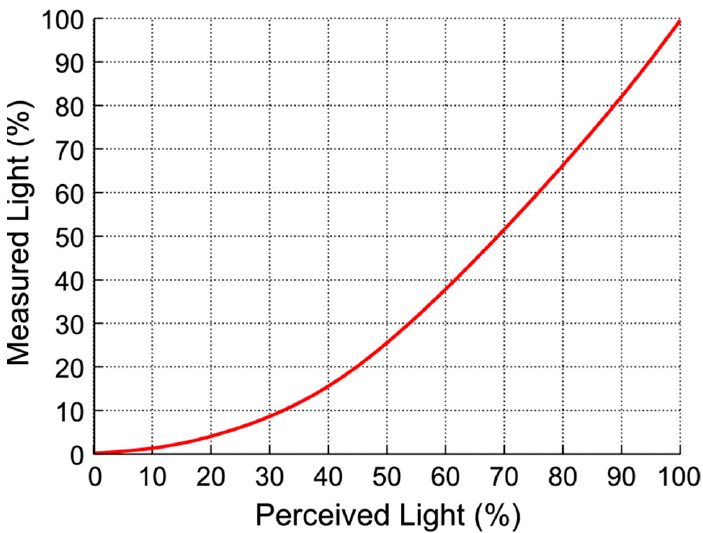
Figure 8. Human eye perceives the actual light differently due to enlargement/contraction of pupil. © 2015 IEEE. Reprinted, with permission from [114] .